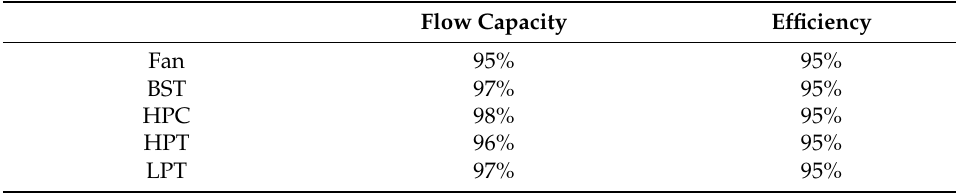
Table 2. Assumed degradation of the concerned component.